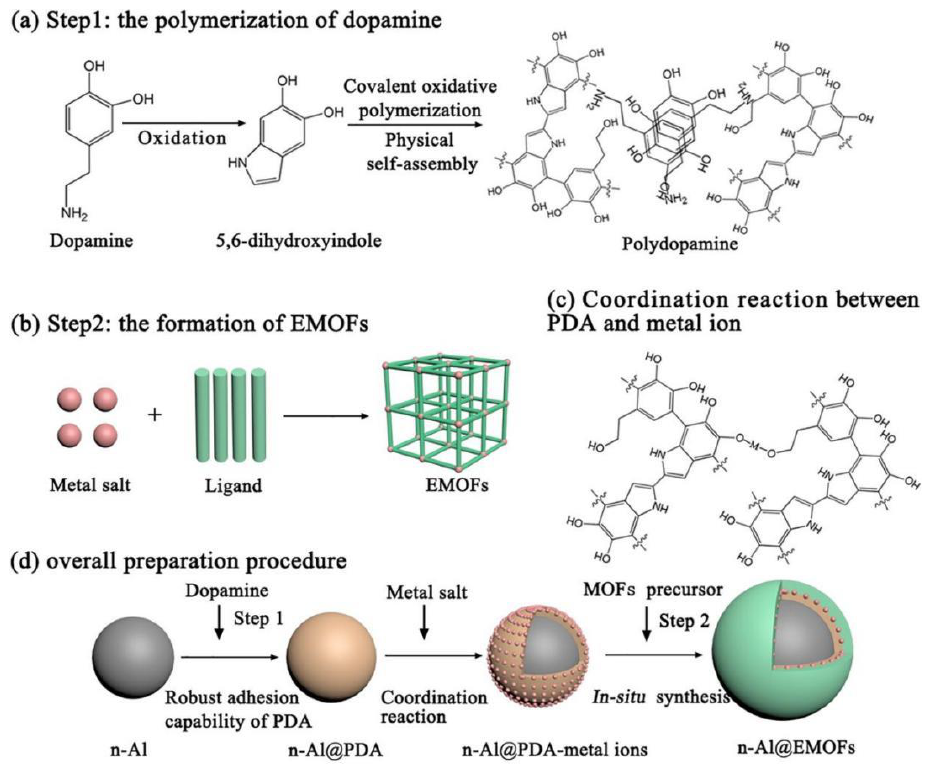
Figure 5. Schematic illustrations of the core-shell n-Al@EMOFs tEMs: ( a ) the polymerization of dopamine; ( b ) the formation of EMOFs; ( c ) metal-chelating reactions between PDA and metal ions; ( d ) the overall preparation procedure [75]. Copyright 2020, Chemical Engineering Journal.